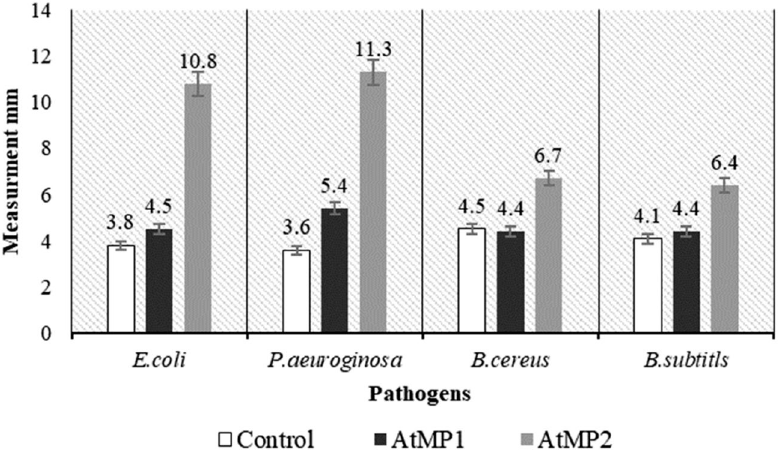
Figure 8. Antibacterial activity of peptides using disk diffusion method. The data were expressed as the mean ± standard deviation (error bar) for three